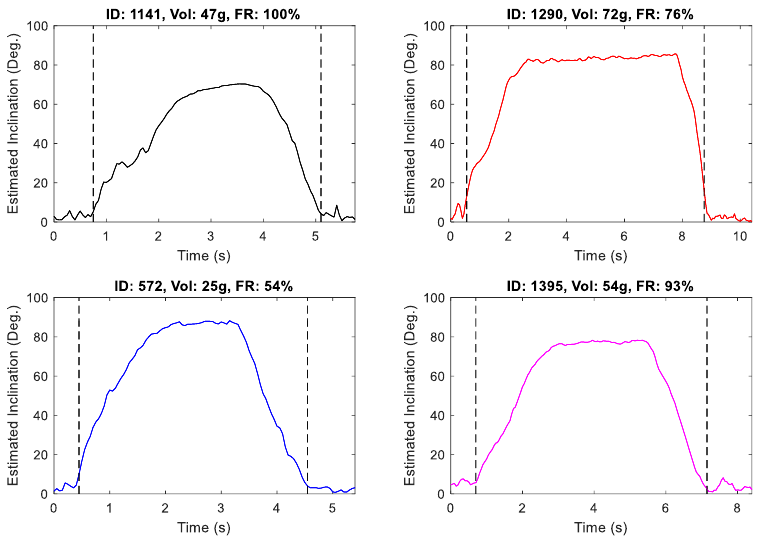
Figure 6. Micro-event partitions for Figure 5 drinks (dashed vertical lines indicate boundaries of sip micro-event).